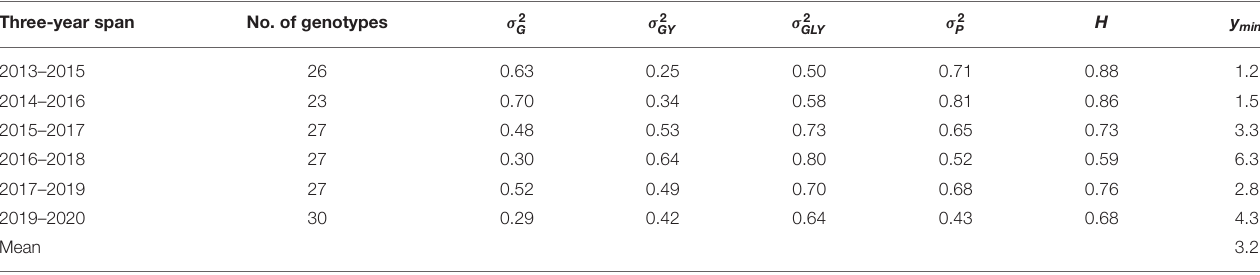
TABLE 2 | The minimum number of years ( y min ) required to achieve a heritability ( H ) of 0.75 estimated on the yield data of three-year spans from the Quebec provincial oat registration trials. Three-year span